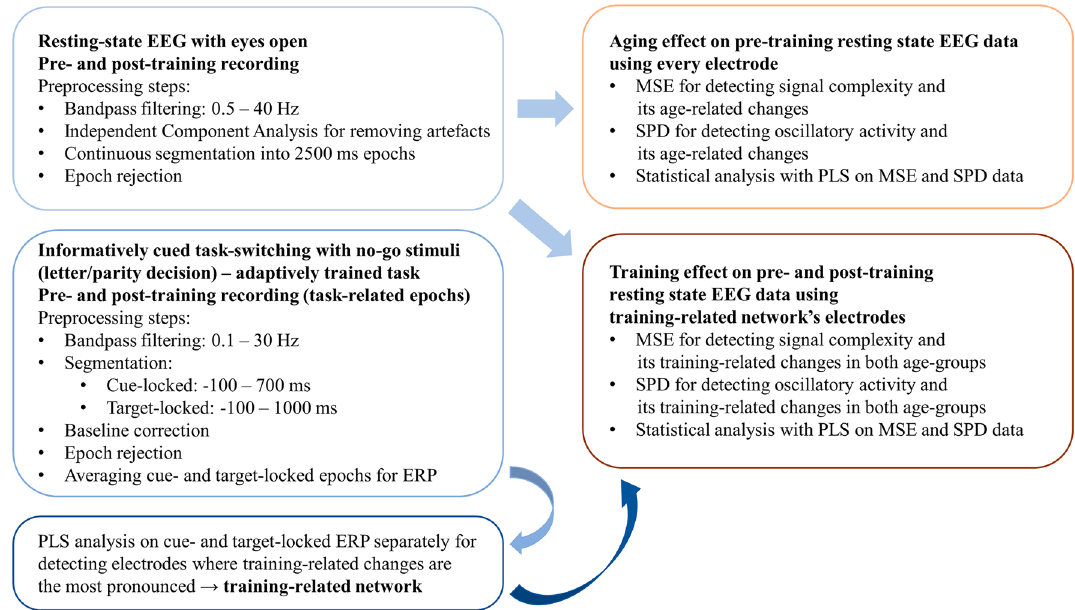
Figure 3. Flowchart and summary of the EEG data processing steps. ERP: event-related potential, MSE: multiscale entropy, SPD: spectral power density, PLS: partial least